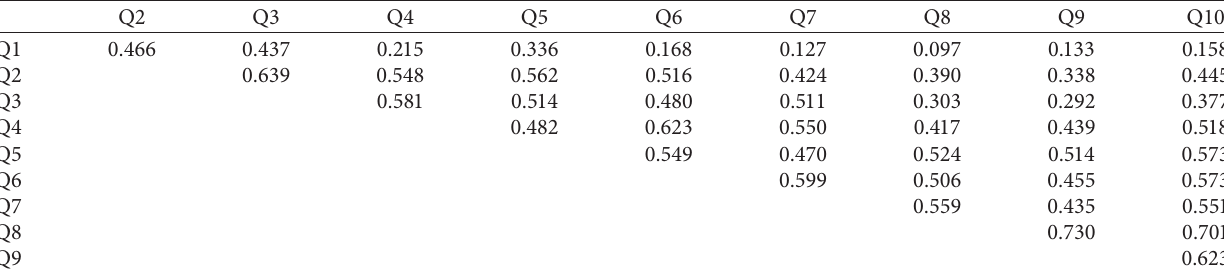
Figure 1: Bivariate correlation between the DLQI score and (a) the age of the patient showing a significant negative correlation between the two and (b) the duration of the disease showing no correlation between the two. Table 3: Interitem correlation matrix of the DLQI